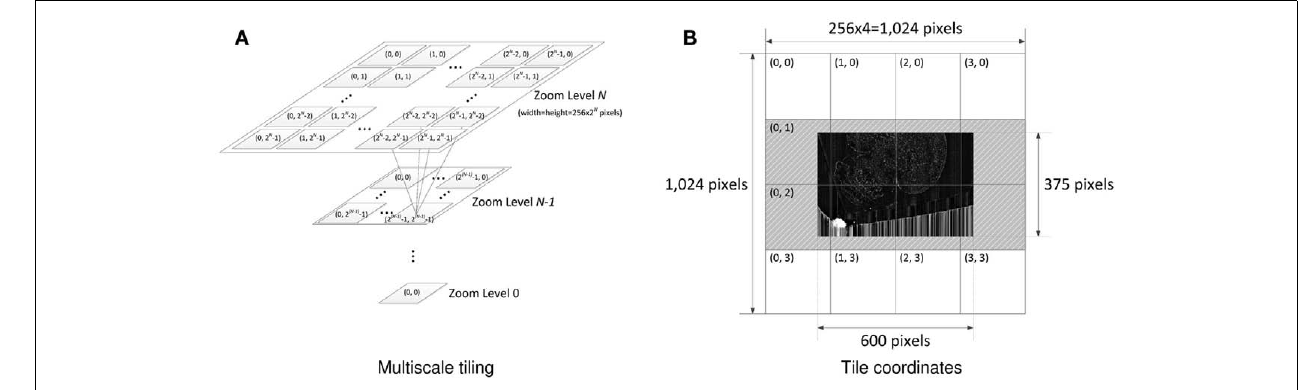
FIGURE 3 | Multiscale tiling. (A) Tile pyramid compatible with GoogleMaps. Quad-tree pyramid of tiles and the x-y coordinate indexing convention are depicted. Each tile has 256 × 256 pixels. Zoom level ranges from 0 to 7, and zoom level N has 2 N × 2 N tiles. Following this tiling convention automatically enables various map functions including zoom-in/out. (B) Example of actual tiles.The maximum zoom level of the Golgi image section (19,200 × 12,000 pixels) is 7 [ = argmin x (256 × 2 x ≥ max(19200,12000))].The minimum zoom level is set to 2.This